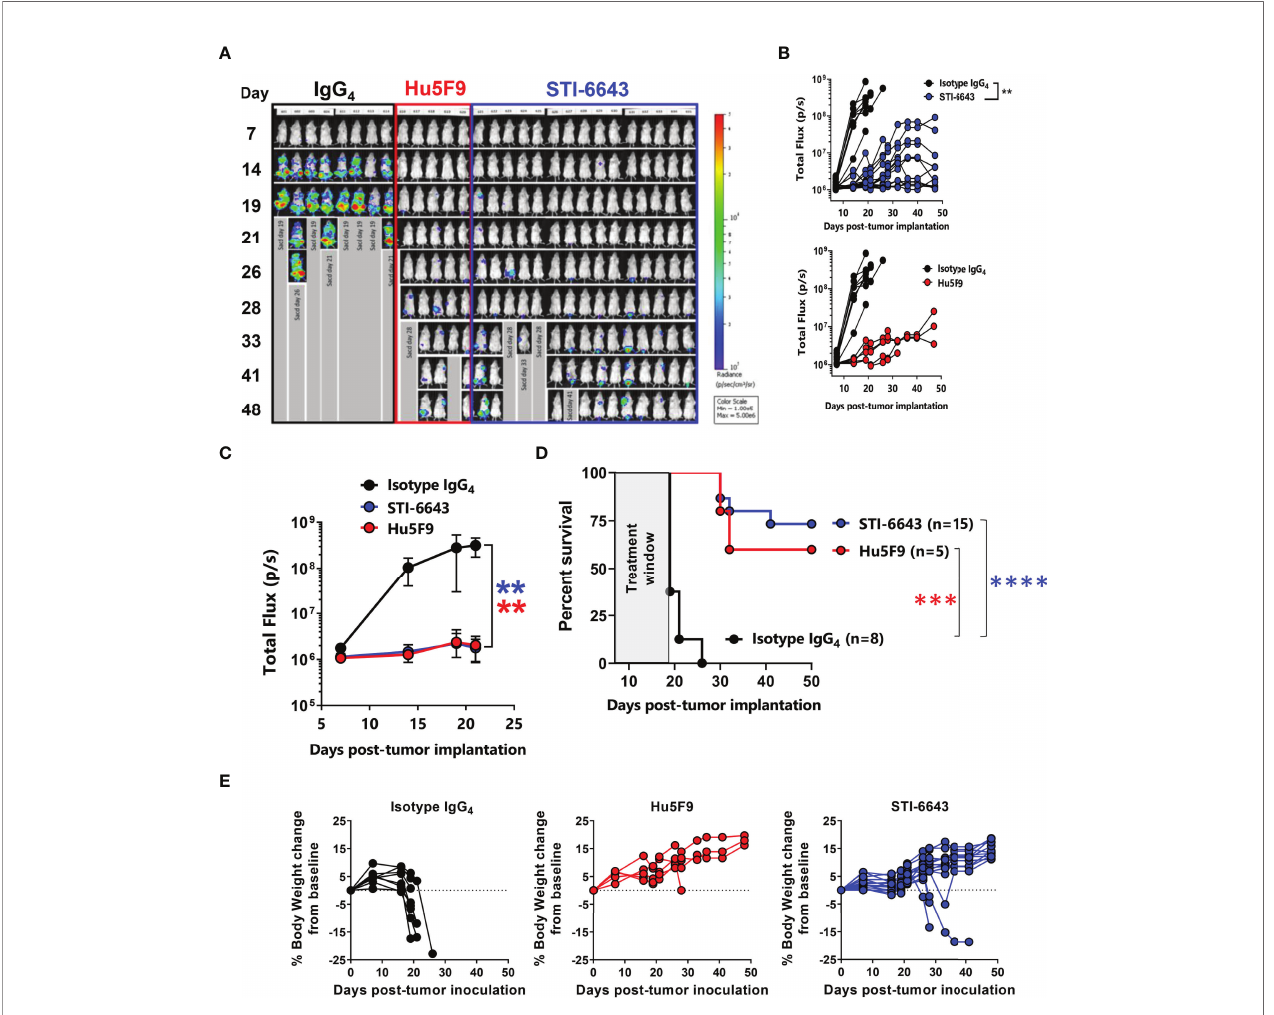
FIGURE 4 | STI-6643 treatment shows comparable anti-tumor activity to reference clone Hu5F9 in the RAJI-Fluc disseminated xenograft model (A-C) Systemic tumor growth was measured by bioluminescence until day 48 post tumor cell implantation. Flux images recorded weekly (A) and bioluminescence fl ux quanti fi cation (B) of animals treated at 30 mpk/injection for 6 doses over a 2-week period with isotype (8 mice, black), STI-6643 (15 mice, blue) or Hu5F9 (5 mice, red). Average fl ux data (C) and survival plots (D) from each treatment group. (E) Percent body weight change from baseline for isotype (left), Hu5F9 (middle) and STI-6643 (right) monitored weekly until study termination. Data are representative of 4 independent experiments and shown as means ± SEM (C, D) ; Statistical signi fi cance assessed by two-way ANOVA (B, C) and log-rank Mantel – Cox test (D) . **p < 0.01, ***p < 0.005, ****p <